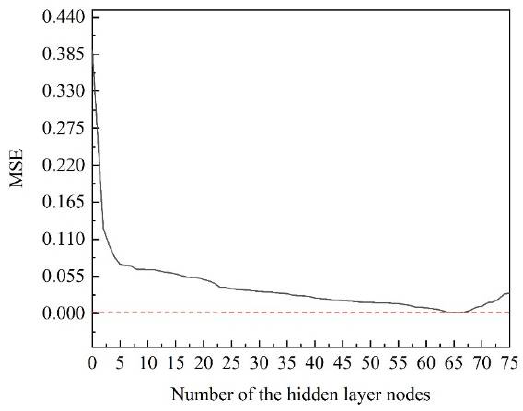
Figure 6. Determination of the number of hidden layer nodes.